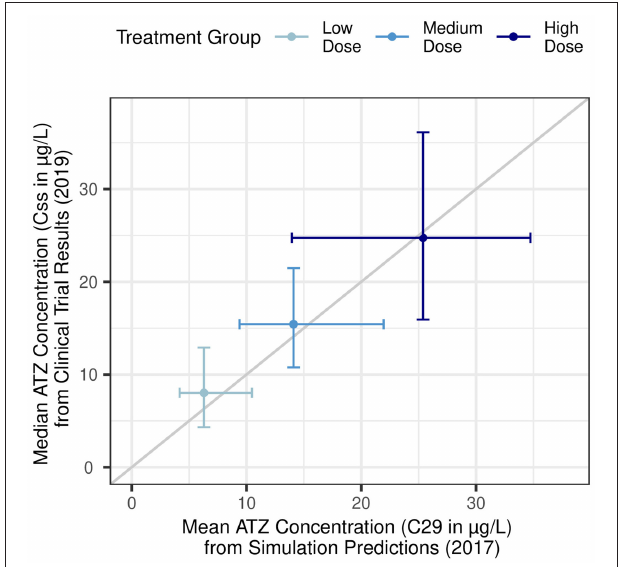
FIGURE 6 | Agreement between pharmacokinetic simulation predictions and subsequent clinical trial results. X-axis: Simulation predictions for mean plasma ATZ concentrations 28 days following ring placement (C 29 ) in low-dose (290 µ g/day), medium-dose (630 µ g/day), and high-dose (1,080 µ g/day) treatment groups. Horizontal error bars represent the 5th and 95th percentiles. Adapted from Reinecke et al. ( 26). Y-axis: Observed median plasma ATZ concentration as average of measurements taken 28, 56, and 84 days following first ring placement (C ss ) in low-dose (300 µ g/day), medium-dose (600 µ g/day), and high-dose (1,050 µ g/day) treatment groups from a phase 2b clinical trial. Vertical error bars represent the 10th to 90th percentile. Adapted from Nave et al. (